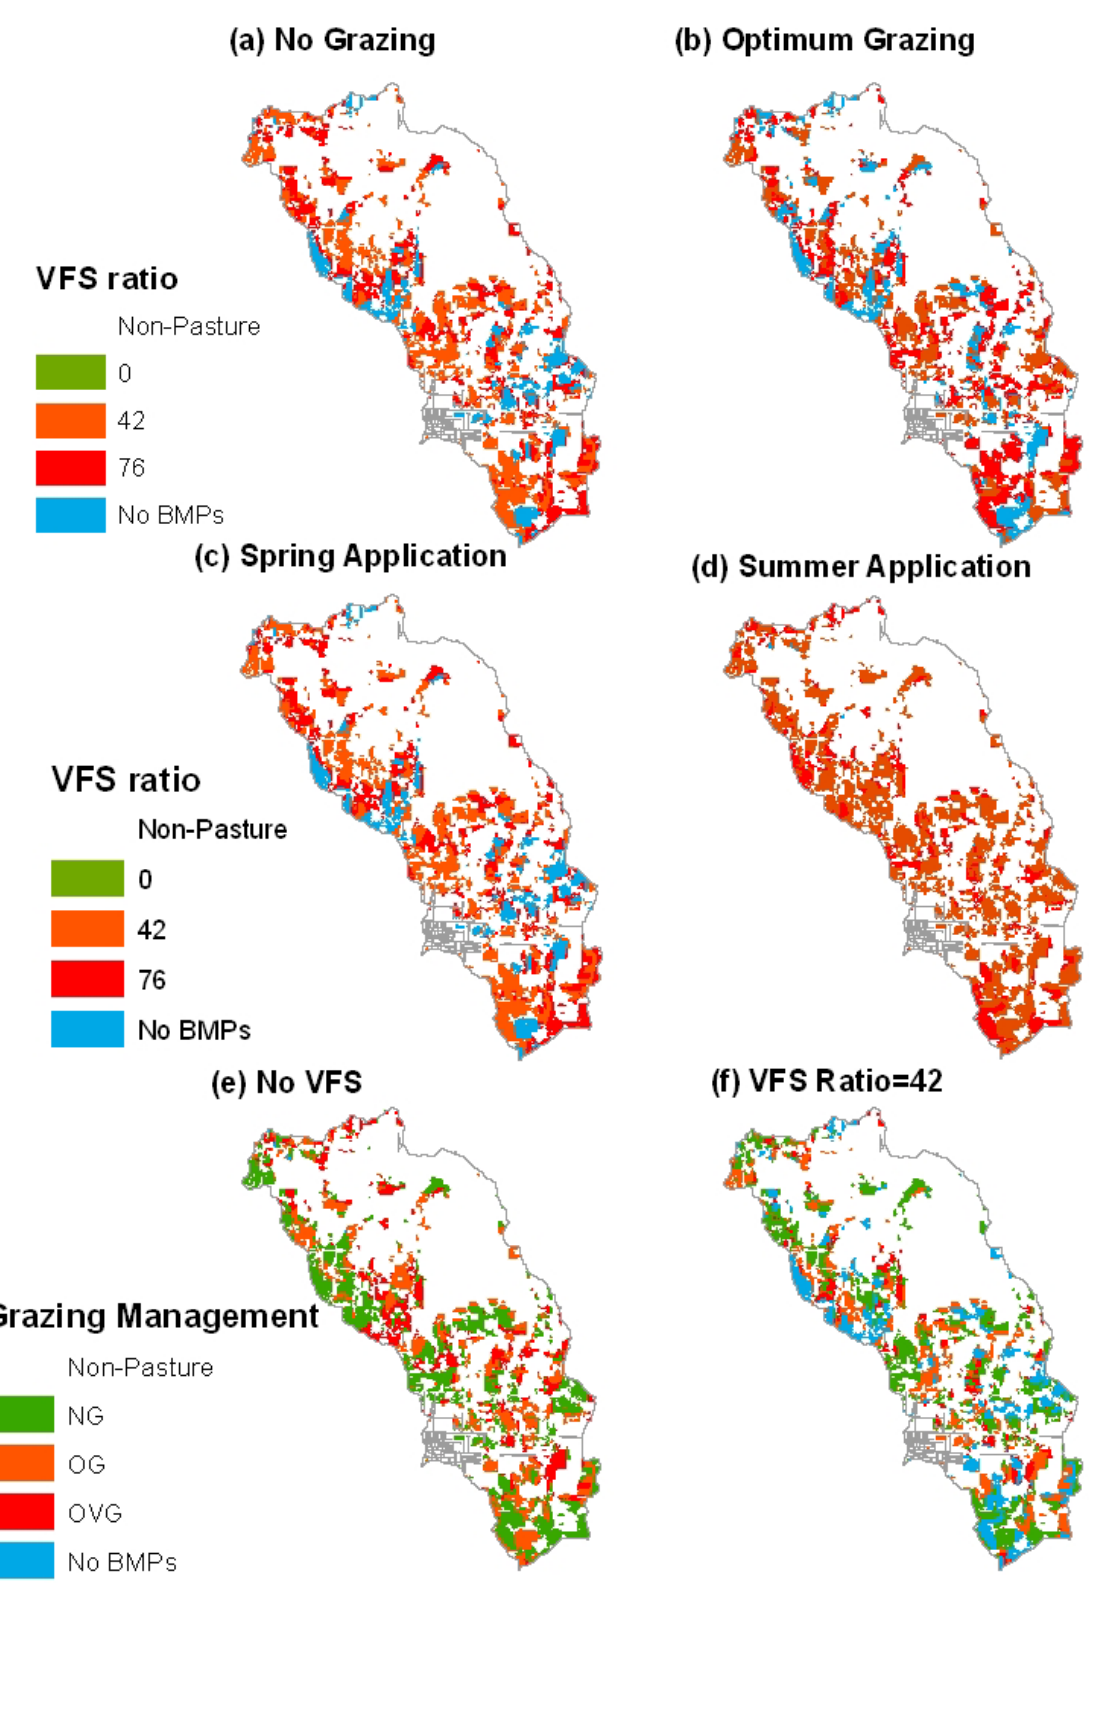
Figure 9. Distribution of selected BMPs from different optimization models to meet the same pollutant reduction of the model with the 171 BMP